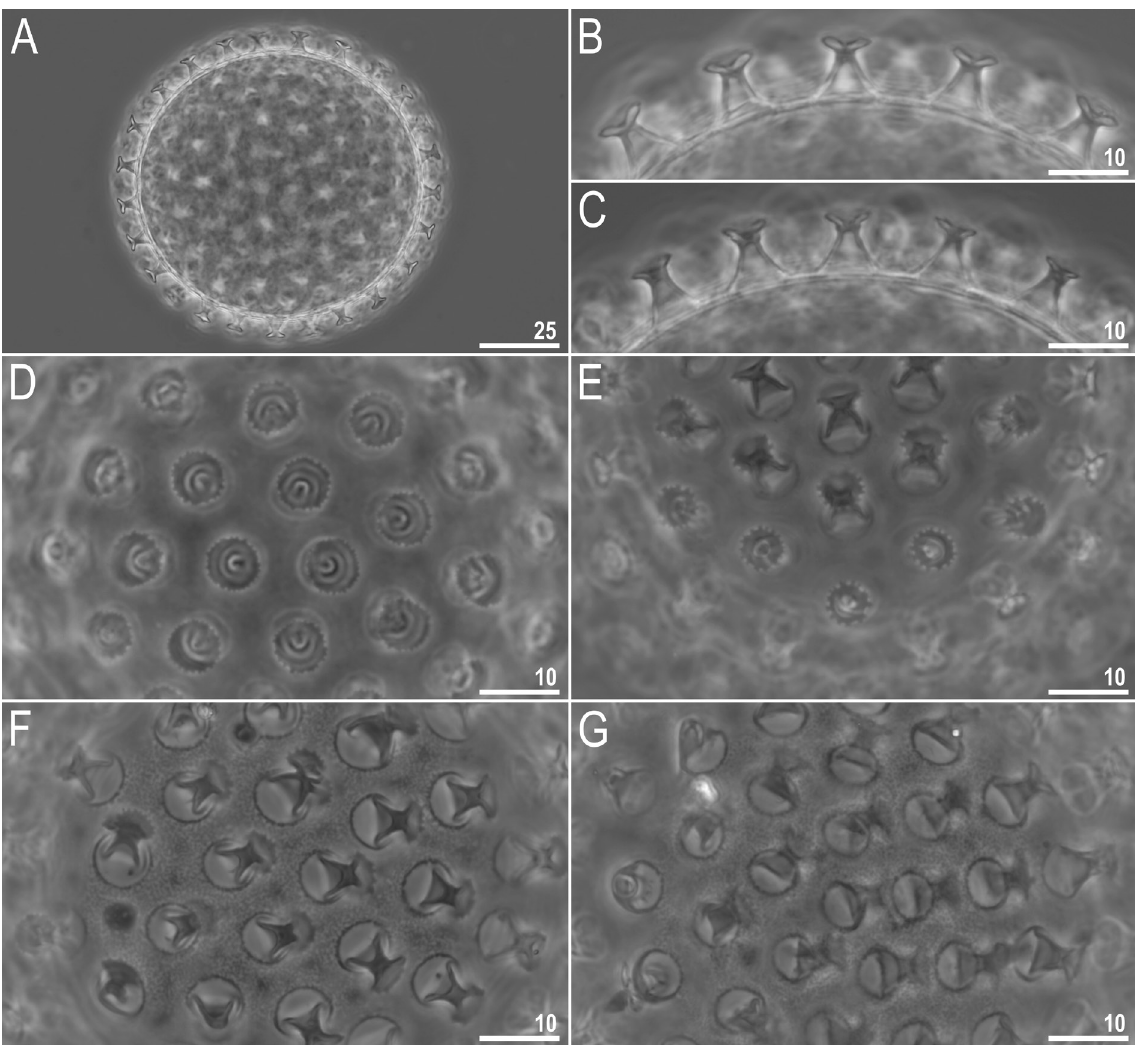
Fig. 7. Macrobiotus engbergi sp. nov. Egg chorion morphology seen in PCM. A . Midsection under 400× magnification. B – C . Midsection under 1000× magnification. D – E . Terminal discs under 1000× magnification. F – G . Surface under 1000× magnification. Scale bars in